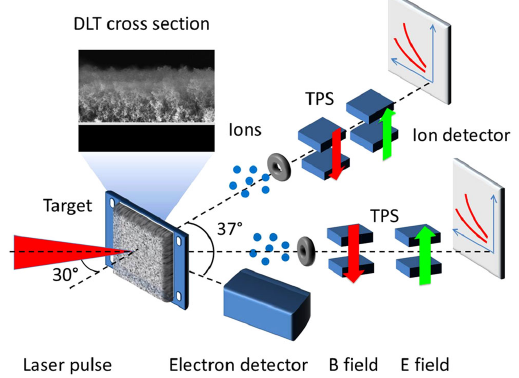
FIG. 1. Setup of the experiment. The laser pulse is tightly focused by an off-axis parabolic mirror (angle of incidence 30°) onto 8 or 12 μ m – thick carbon foam deposited on a 0 . 75 μ m – thick Al foil. Ion spectra are recorded using two Thomson parabola spectrometers (TPS) and electron spectra are collected with an electron